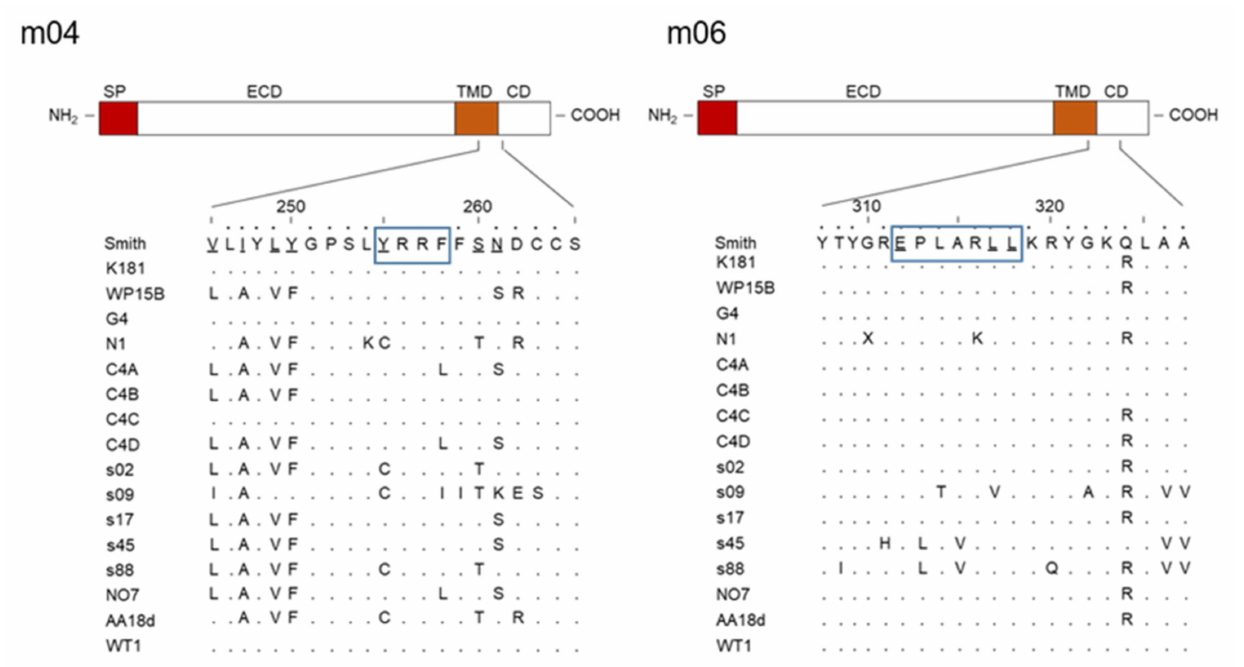
Figure 2. High evolutionary conservation of m04 and m06 cargo sorting motifs in strains